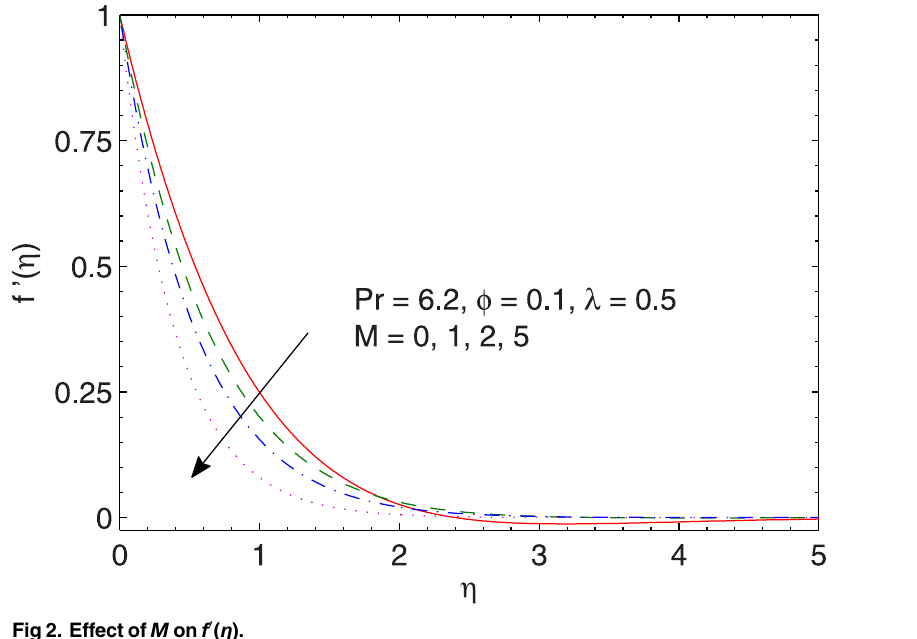
Fig 2. Effect of M on f 0 ( η ).